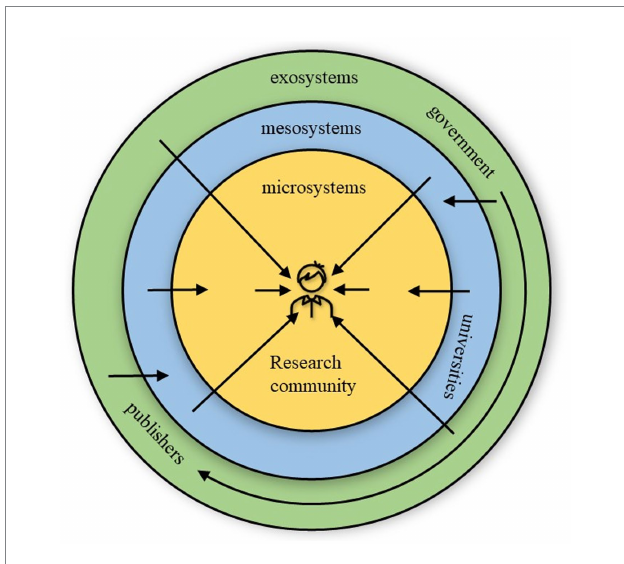
FIGURE. 4 Ecological model for overcoming EFL teachers’